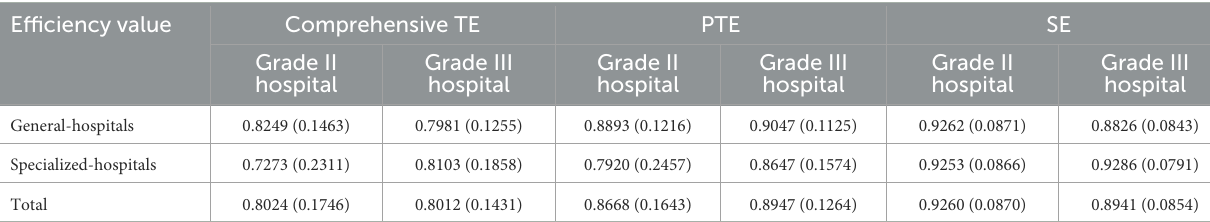
TABLE 7 Average efficiency of public hospitals with different levels and